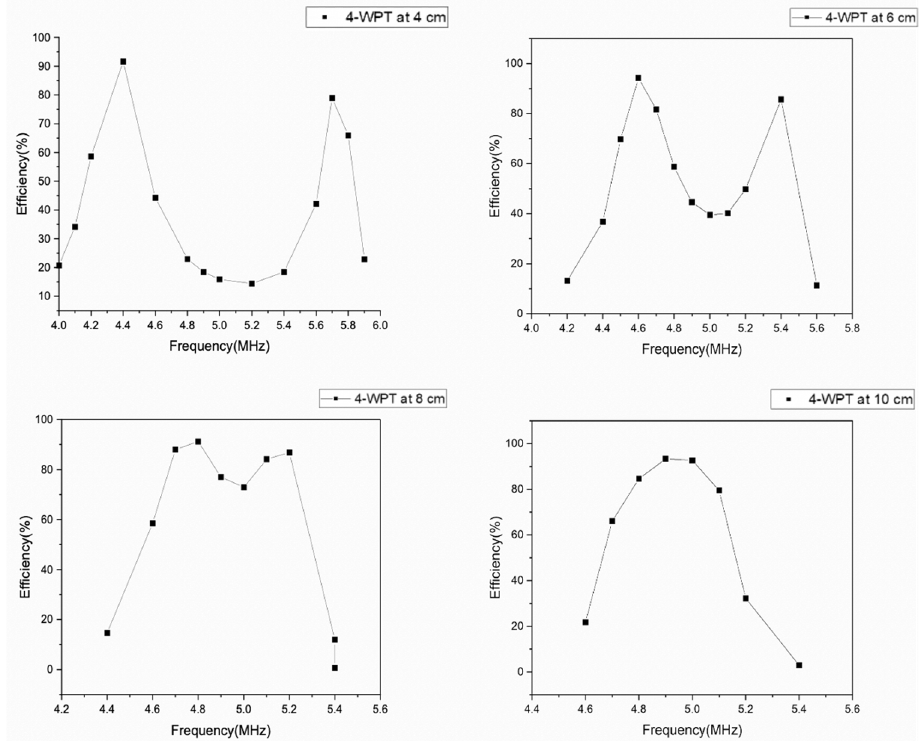
Figure 7. The MR-WPT efficiency of the four-coil system analyzed in frequency domain at a sepa- ration of 4 cm, 6 cm, 8 cm and 10